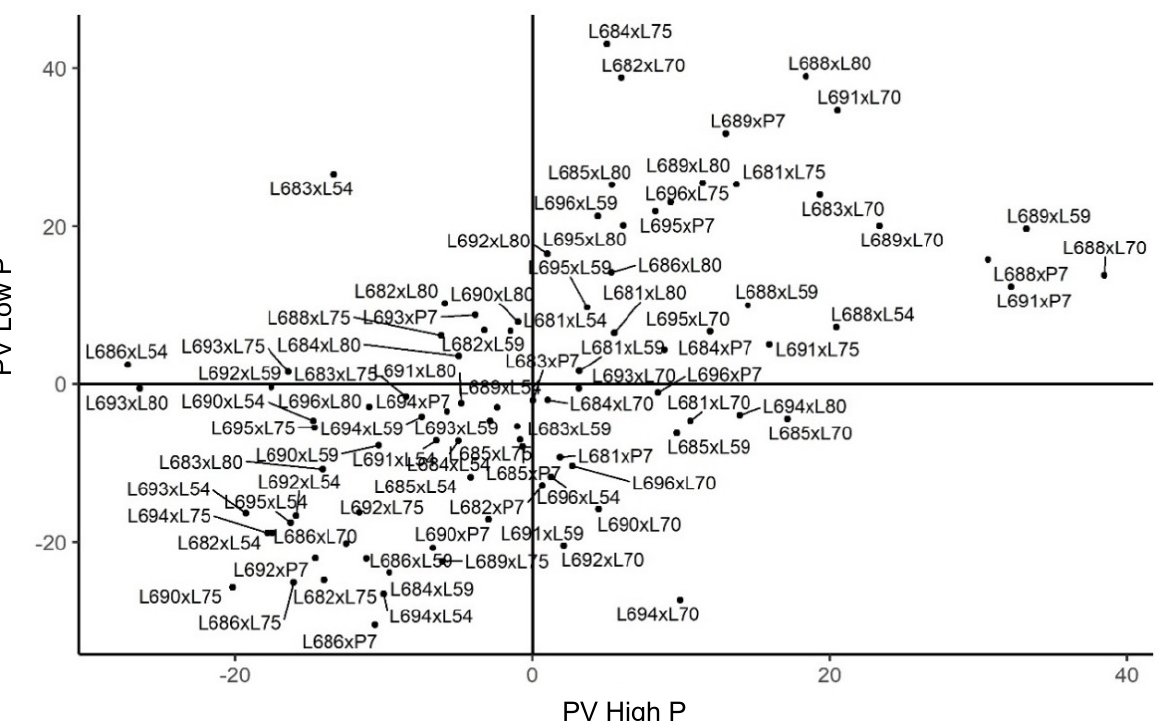
Figure 7. Estimates of the genotypic value (ˆ s ij ) for expanded popcorn volume per hectare (PV) in diallel hybrids of popcorn evaluated under high and low phosphorus availability in Campos dos Goytacazes. (-) signal indicating negative values.